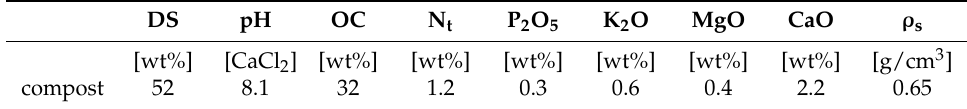
Table 9. Average dry substance content (DS), pH value, nutrient and organic carbon (OC), and particle density ( ρ s ) of the compost made out of trees and shrubs (Rastorf, Northern Germany). DS pH OC